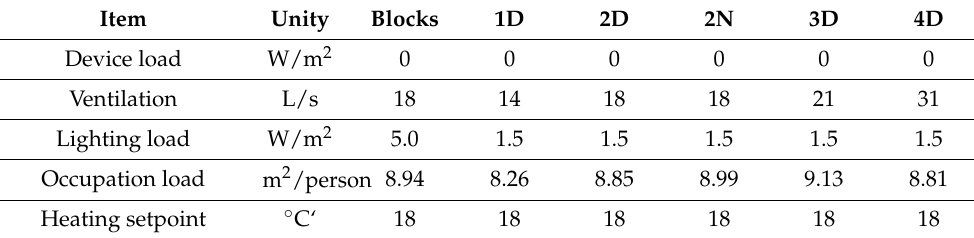
Table A3. Loads for devices, lighting, occupation, ventilation, and slogans for simulations. Item Unity Blocks 1D 2D 2N 3D 4D Device load W/m 2 0 Ventilation L/s Lighting load